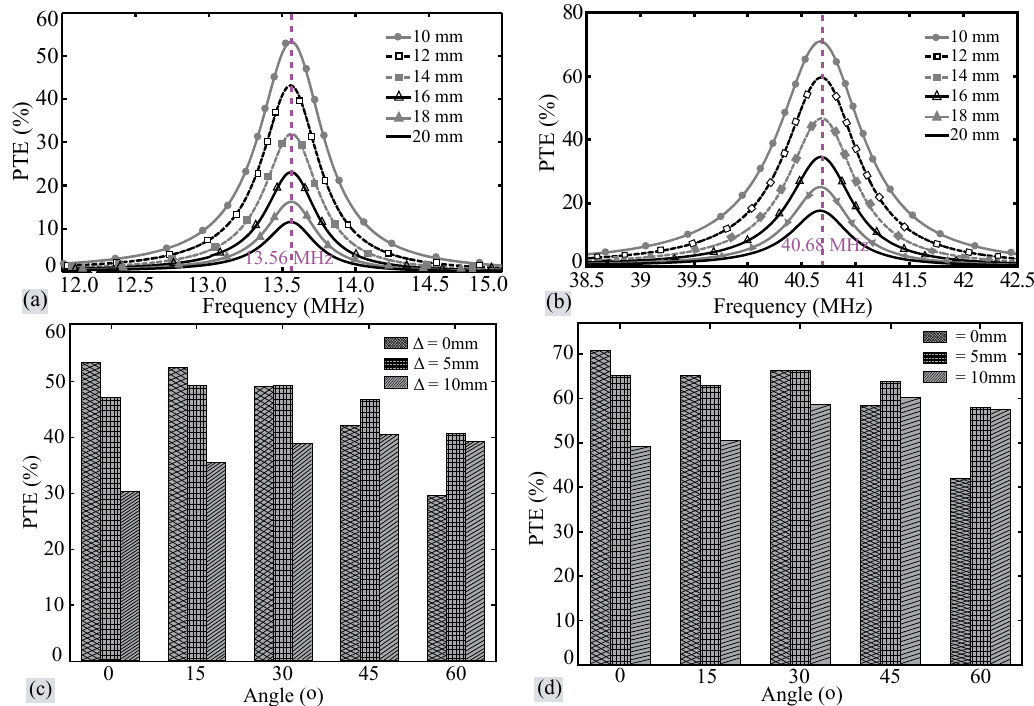
Figure 5. ( a ) PTE vs. frequency vs. distance at 13.56 MHz; ( b ) PTE vs. frequency vs. distance at 40.68 MHz; PTE vs. alignment configurations at ( c ) 13.56 MHz; ( d ) 40.68 MHz.